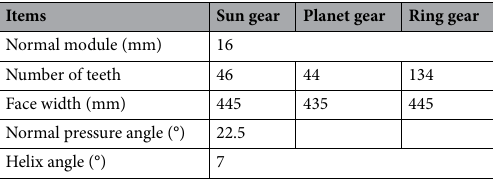
Table 1. The main specifications of the first PGS.